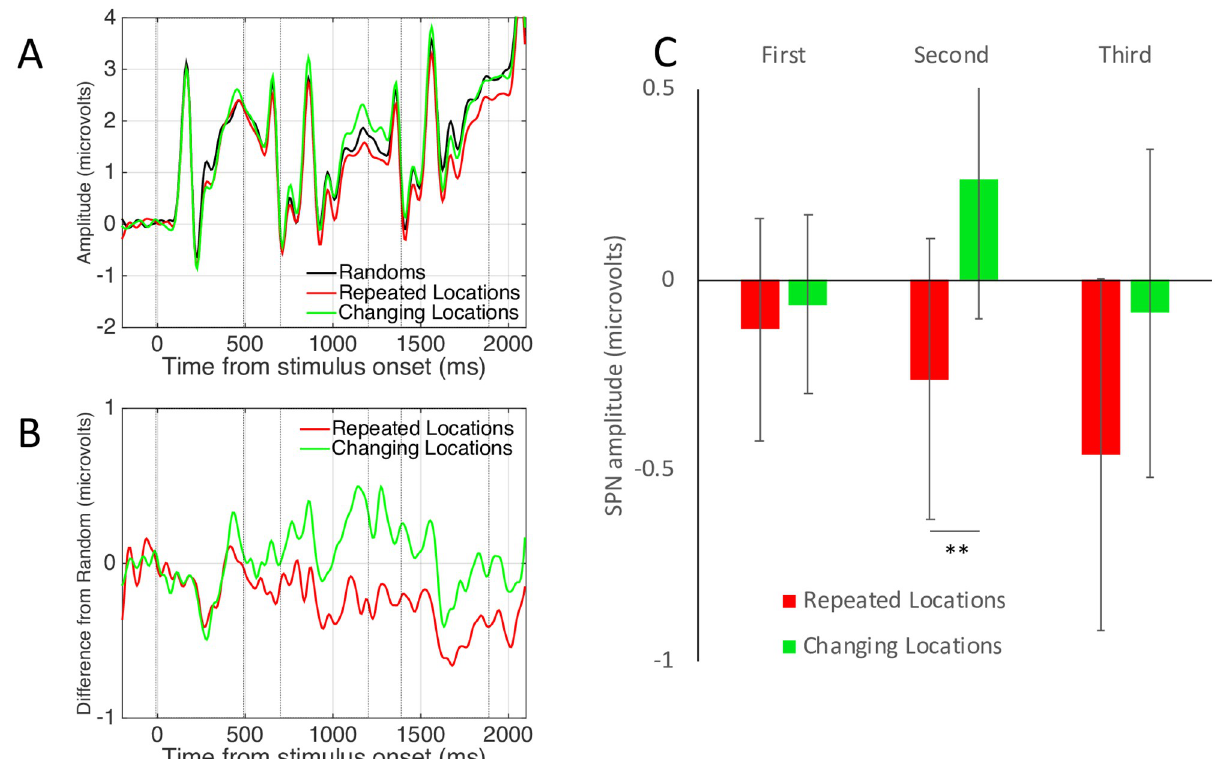
Fig 6. Experiment 2 results. Conventions are the same as Fig 3. A) Grand Average ERPs from electrode cluster O1, PO7, O2 and PO8. B) Difference waves as difference from the double random condition. C) Mean SPN for first, second and third intervals. Error bars = 95% confidence intervals. Stars show significant pairwise comparisons (p < 0.01) Note SPN priming in the repeated locations condition (red), but not in the changing locations condition (green).